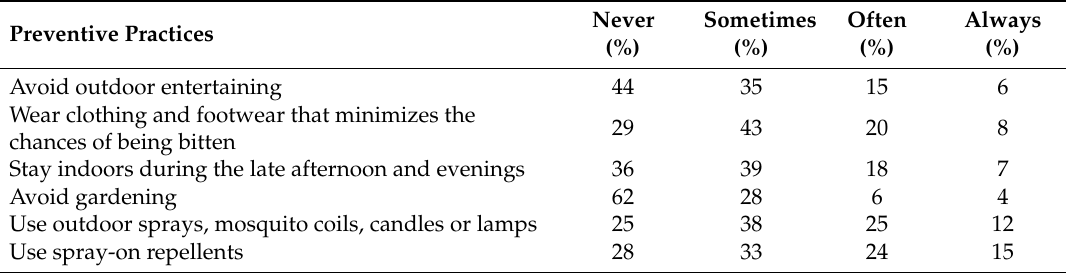
Table 2. Preventive practices used to avoid mosquitoes around the